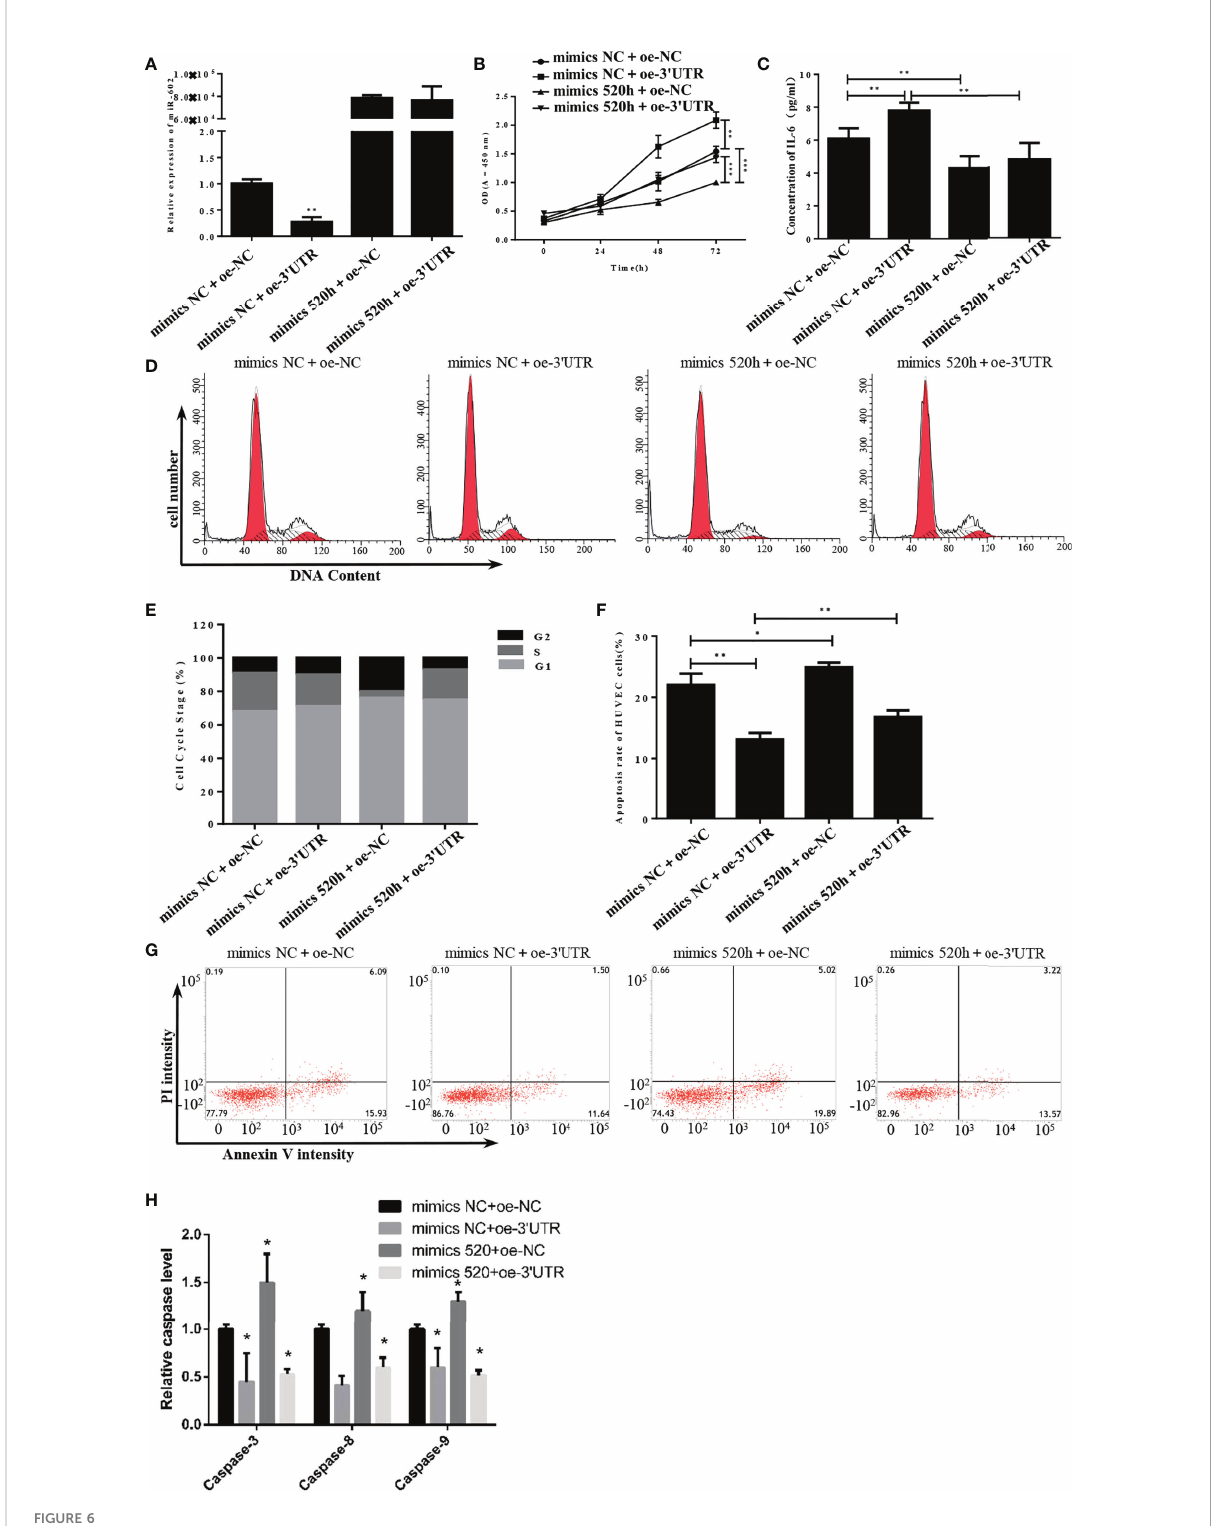
FIGURE 6 S-3 ′ UTR disturbed growth of HUVECs by knock-down of miR-520h. (A) Level of miR-520h in HUVECs. (B) HUVEC proliferation induced by overexpression of S-3 ′ UTR was reduced by miR-520h mimics. (C) Increased IL-6 level induced by overexpression S-3 ′ UTR was reduced by miR- 520h mimics. (D-G) Effects of S-3 ′ UTR on HUVECs cell cycle could not be recovered by miR-520h mimics. (E, F) Apoptosis of HUVECs induced by overexpression of S-3 ′ UTR was partially reduced by miR-520h mimics. (H) caspase-3/8/9 assay to check apoptosis. (*p<0.05, **p<0.01,